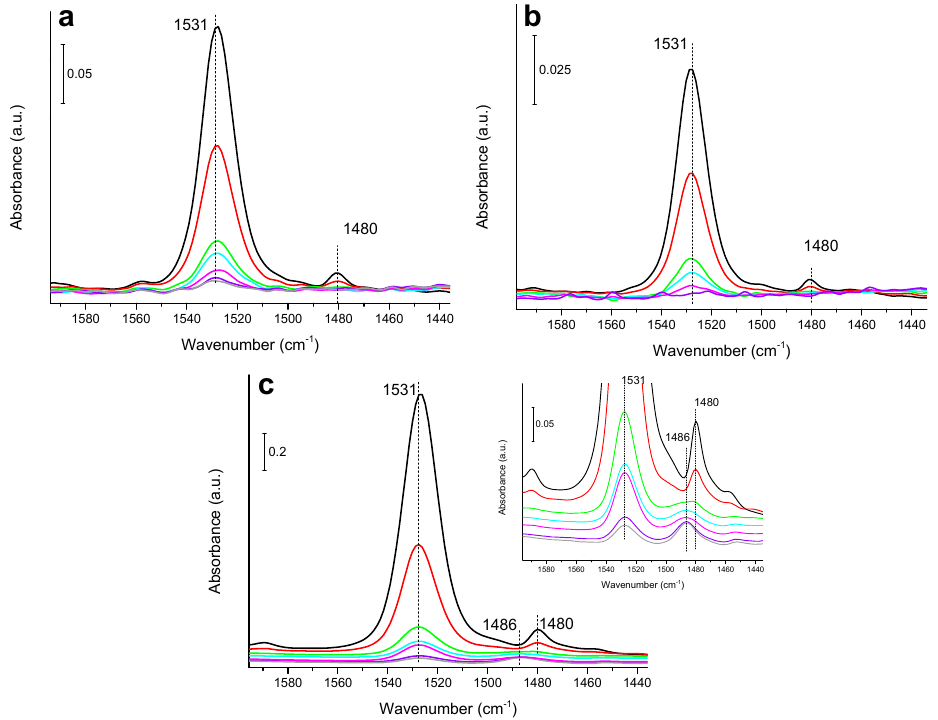
Figure 1. IR spectra of nitrobenzene adsorption on: ( a ) Cu/SiO 2 , ( b ) Pd/SiO 2 and ( c ) Ni/SiO 2 (in the inset a zoom of the bottom part of the IR spectra), and their evolution with the temperature: 25 °C (black), 60 °C (red), 120 °C (green), 140 °C (cyan), 160 °C (magenta), 180 °C (violet) and 200 °C (grey).